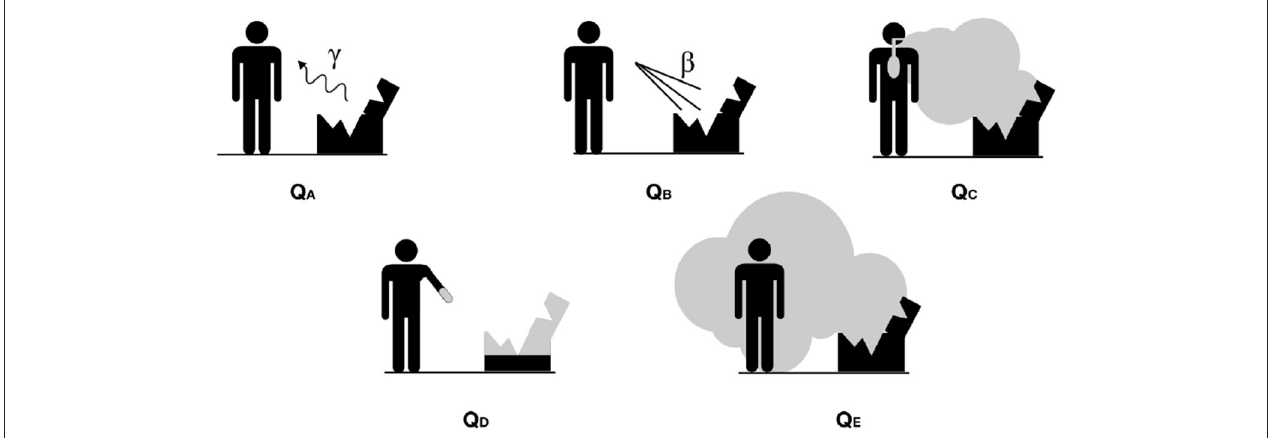
FIGURE 1 | Schematic representation of the exposure pathways included in the Q system.